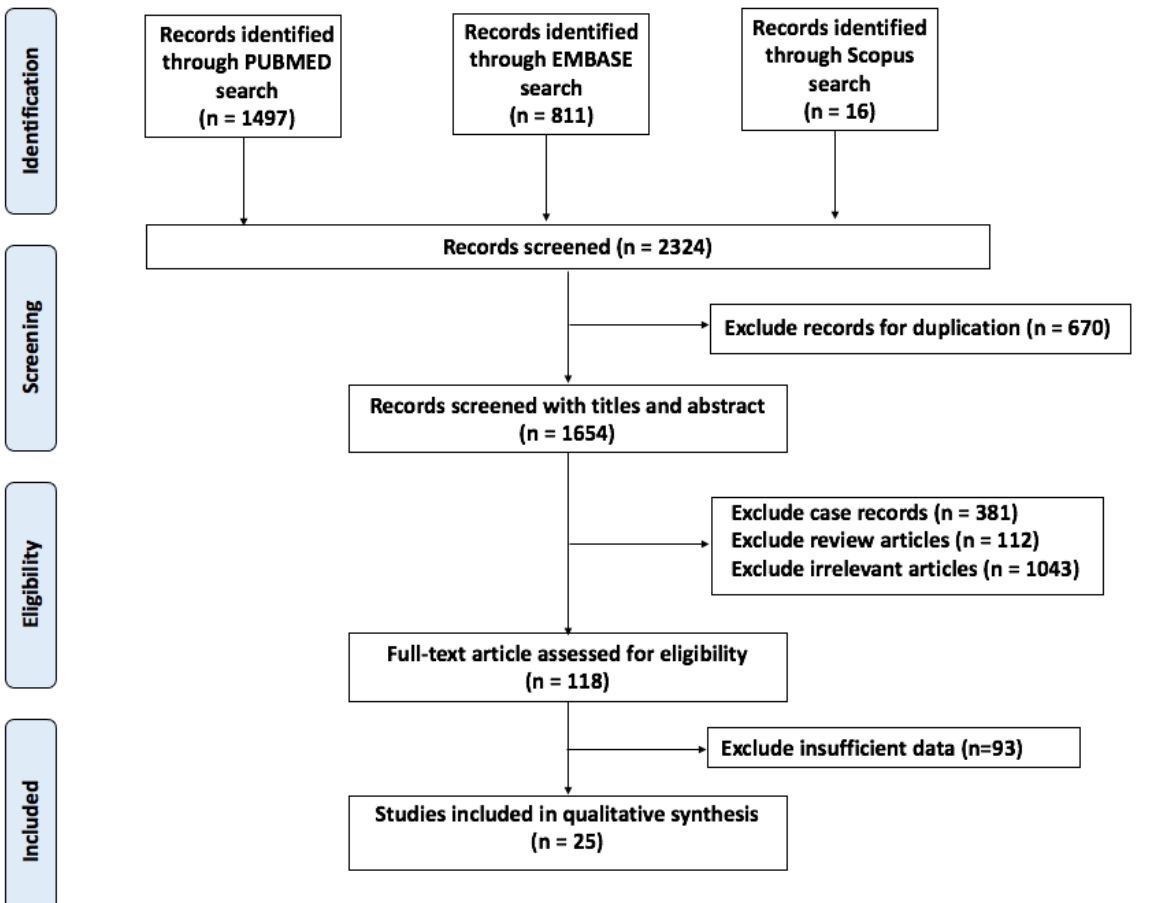
Figure 1. Workflow of the literature search. A total of 25 studies were included.